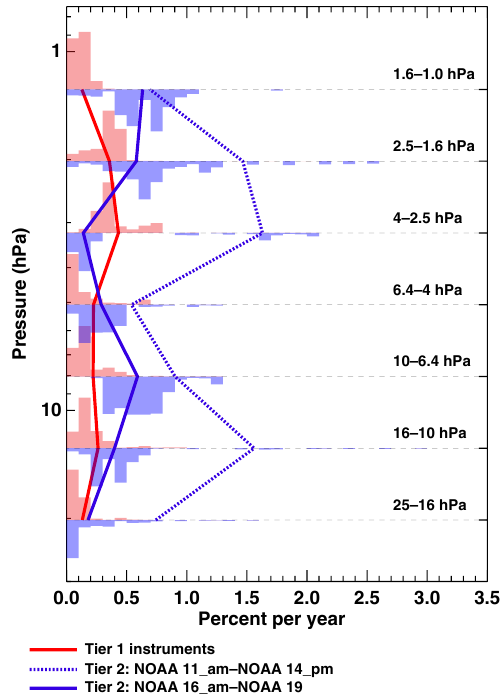
Figure 5. Mean offset parameters as a function of pressure level derived from Tier 1 (Nimbus 7, NOAAs 11_pm, 16_pm, 17, 18 and 19) and Tier 2 (NOAAs 11_am, 14_pm, 14_am and 16_am) instrument overlaps used in Monte Carlo simulations to evaluate the uncertainty of potential offsets and drifts on final merged ozone record. The parameters are the weighted root mean square of the collection of mean offsets computed in each 5 ◦ latitude bin and each overlapping instrument pair. The probability distribution for the Tier 1 instruments is shown by the red shaded histogram at each pressure level, while the probability distribution for the Tier 2 in- struments is shown by the blue shaded histogram (shown upside down to separate it from the Tier 1 distribution).